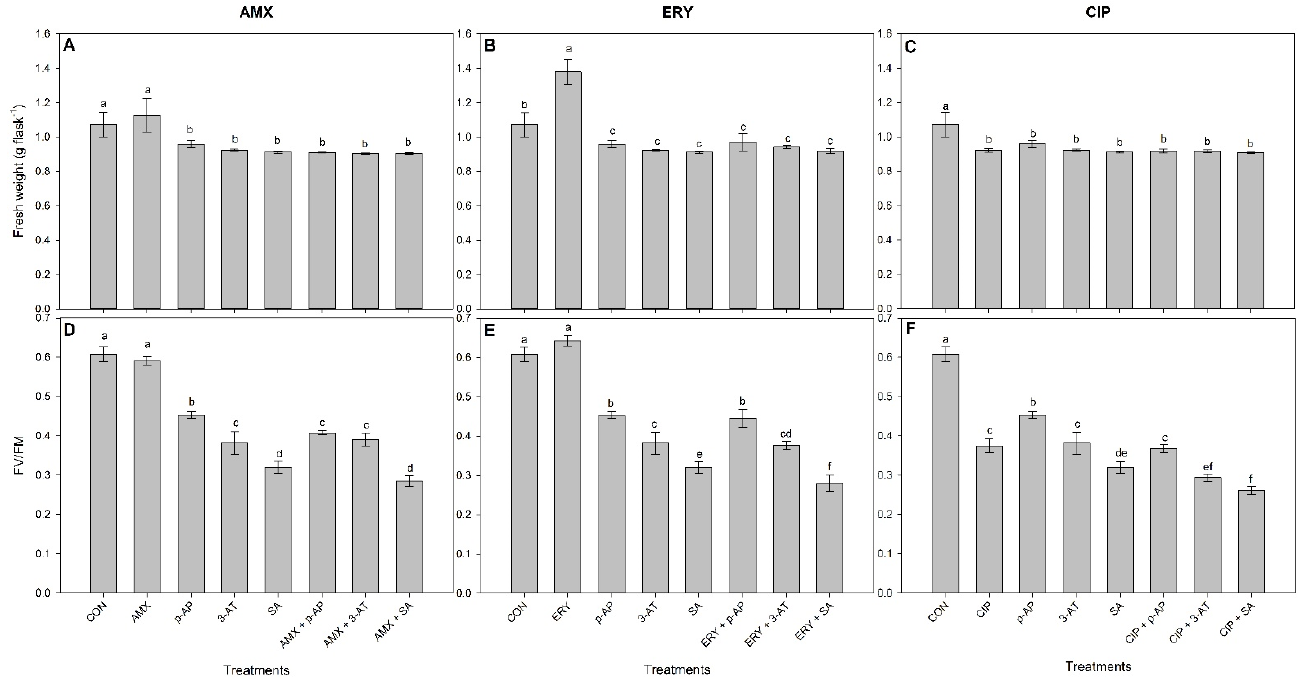
Figure 2. Fresh weight ( A – C ) and quantum yields of photosystem II (FV/FM; D – F ) in L. minor plants exposed to isolated or combined concentrations of antibiotics and antioxidant-enzyme inhibitors for seven days. Bars represent the means ± SD of four replicates. Different letters indicate significant differences ( p > 0.05) using the post hoc Tukey test. CON = control; AMX = 2 µg amoxicillin L − 1 ; ERY = 1.7 µg erythromycin L − 1 ; CIP = 1.05 mg ciprofloxacin L − 1 ; p -AI = 5 mM p -aminophenol; 3-AT = 200